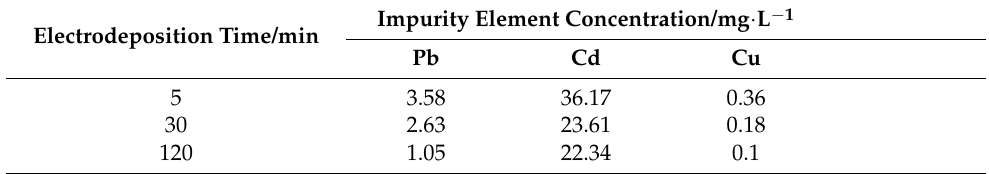
Table 4. The content of impurity elements in the solution after electrochemical impurity removal.